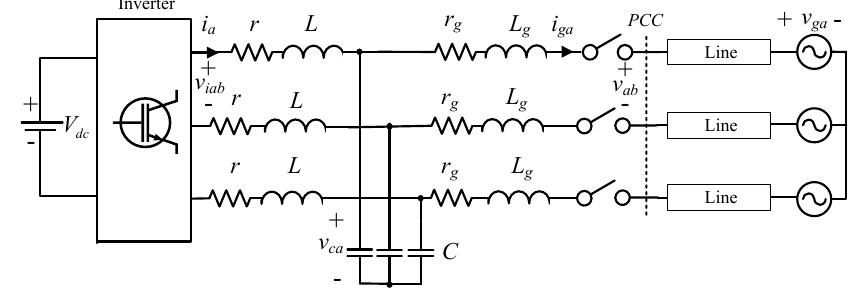
Figure 1. Three-phase inverter connected to the grid through an LCL